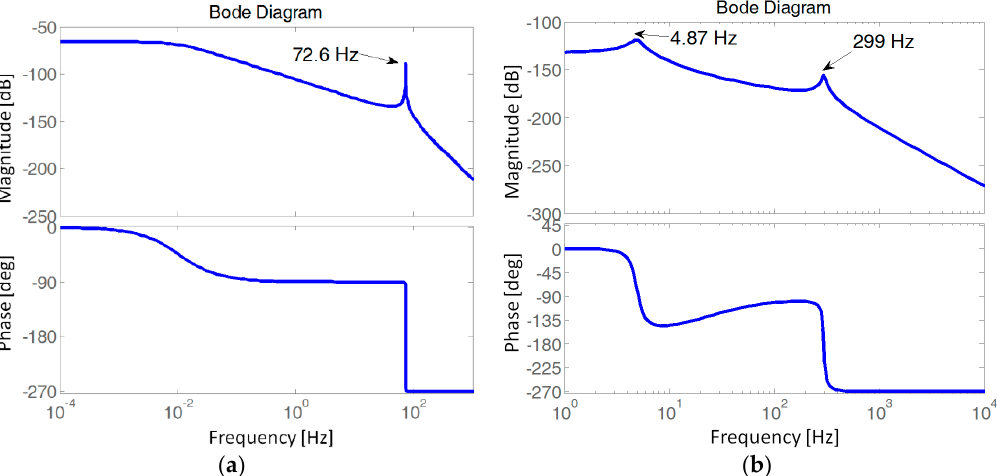
Figure 4. Bode diagram of the mechatronic model of the power chain of the 100-kW wind turbine. ( a ) Case of one resonance peak, when ω g = 502 rpm, ( b ) Case of two resonance peaks, when ω g = 650 rpm.